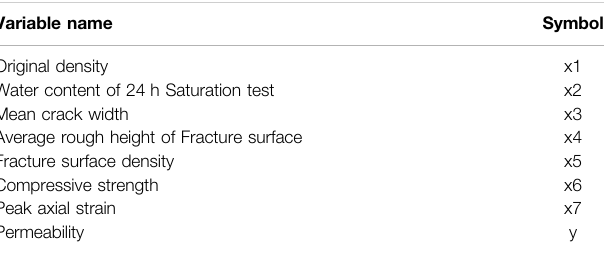
TABLE 3 | Correspondence between variable data and